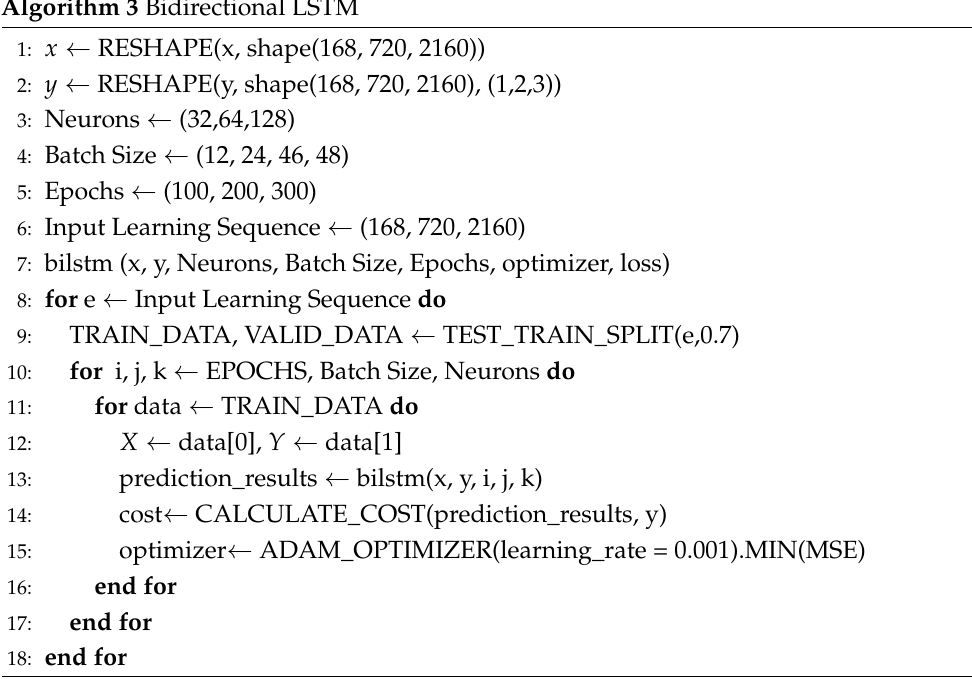
Algorithm 3 Bidirectional